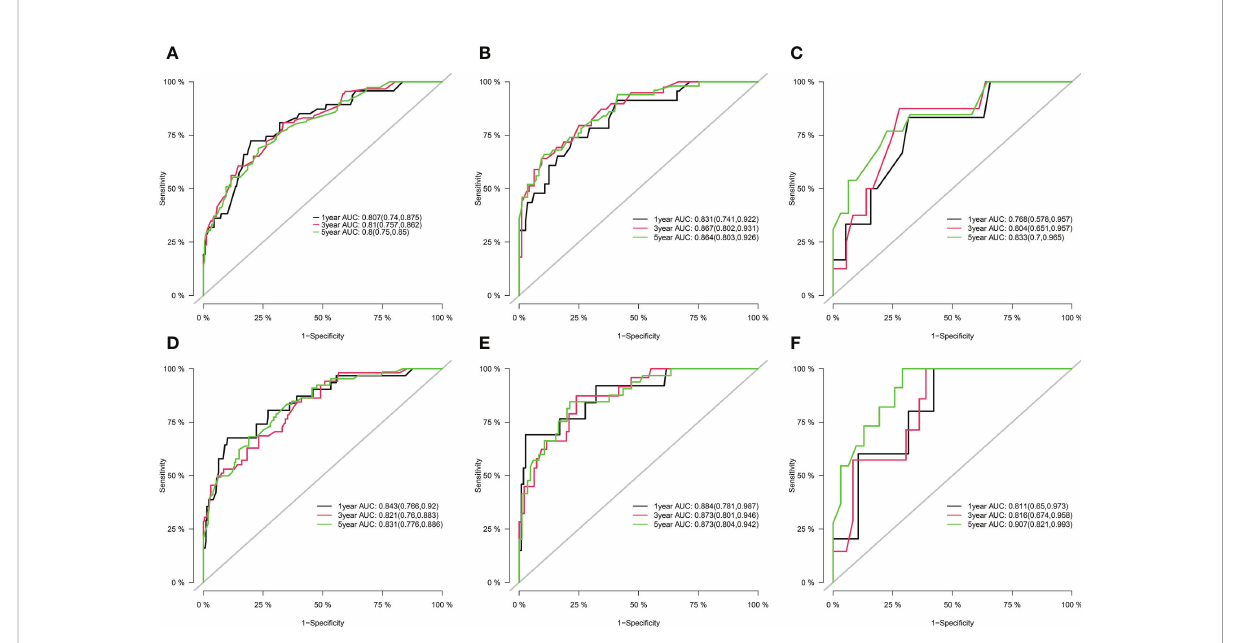
FIGURE 2 ROCs curve for the nomograms in predicting prognosis in patients with Colorectal GISTs. (A) ROC of 1-, 3- and 5-year OS in the training cohort; (B) ROC of 1-, 3- and 5-year OS in the internal validation cohort; (C) ROC of 1-, 3- and 5-year OS in the external validation cohort; (D) ROC of 1-, 3- and 5-year CSS in the training cohort; (E) ROC of 1-, 3- and 5-year CSS in the internal validation cohort; (F) ROC of 1-, 3- and 5-year CSS in the external validation cohort. ROC, receiver operating characteristic; OS, overall survival; CSS, cancer-speci fi c survival; Colorectal GISTs, Colorectal gastrointestinal stromal tumors.